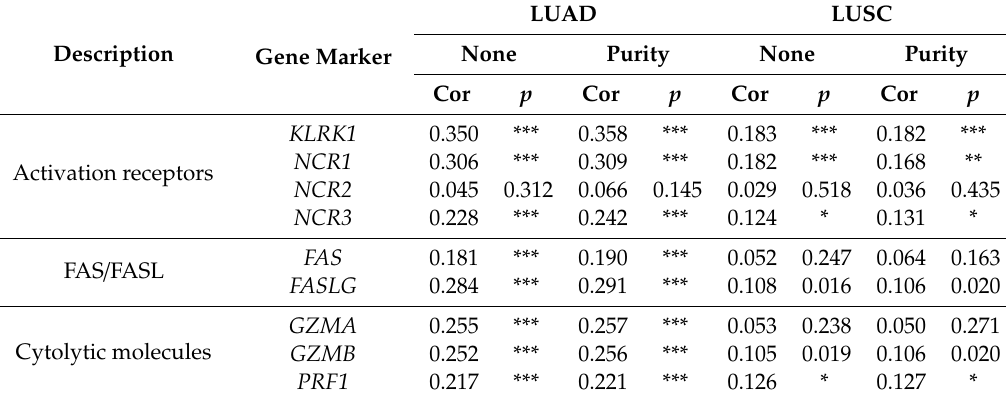
Table 3. Analysis of correlation between natural killer (NK) cell-mediated cytotoxicity marker genes and ATP / GTP binding protein 1 ( AGTPBP1 ) expression using tumor immune estimation resource (TIMER)